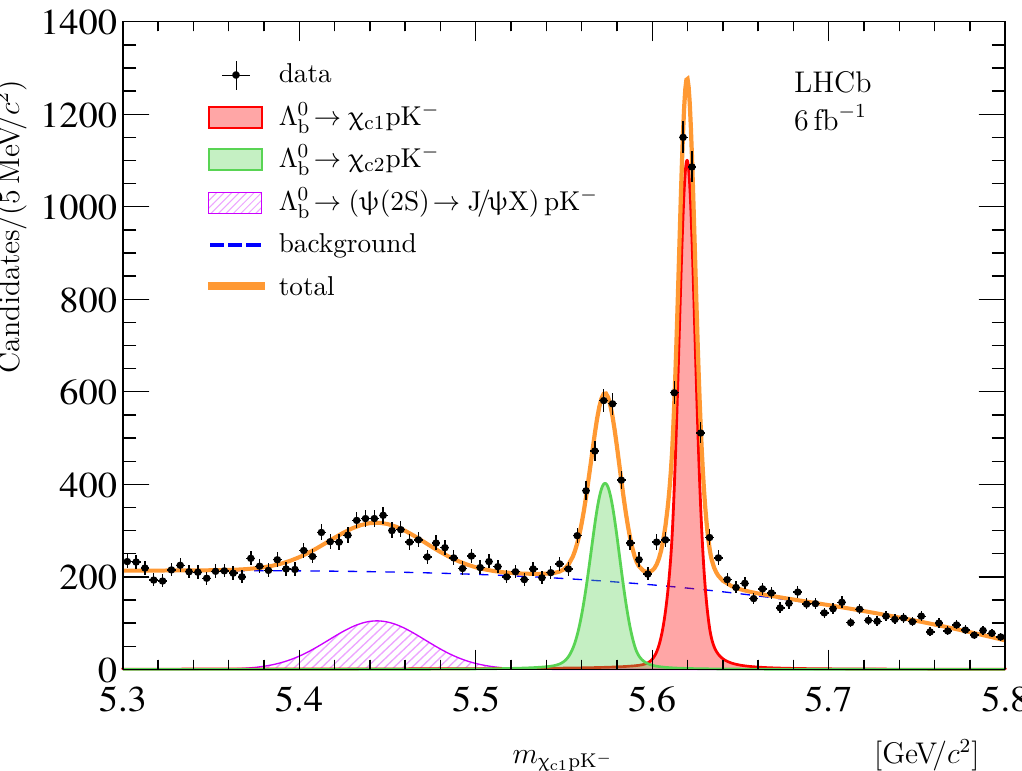
→ (cid:31) cJ pK − candidates. A fit, described in the text, b